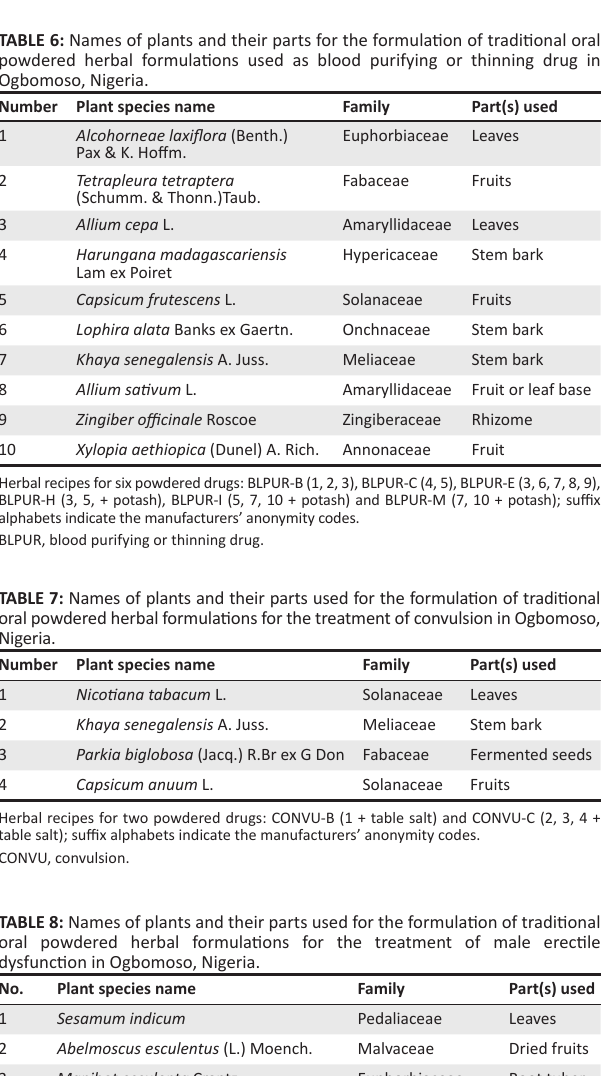
Abelmoscus esculentus (L.) Moench.